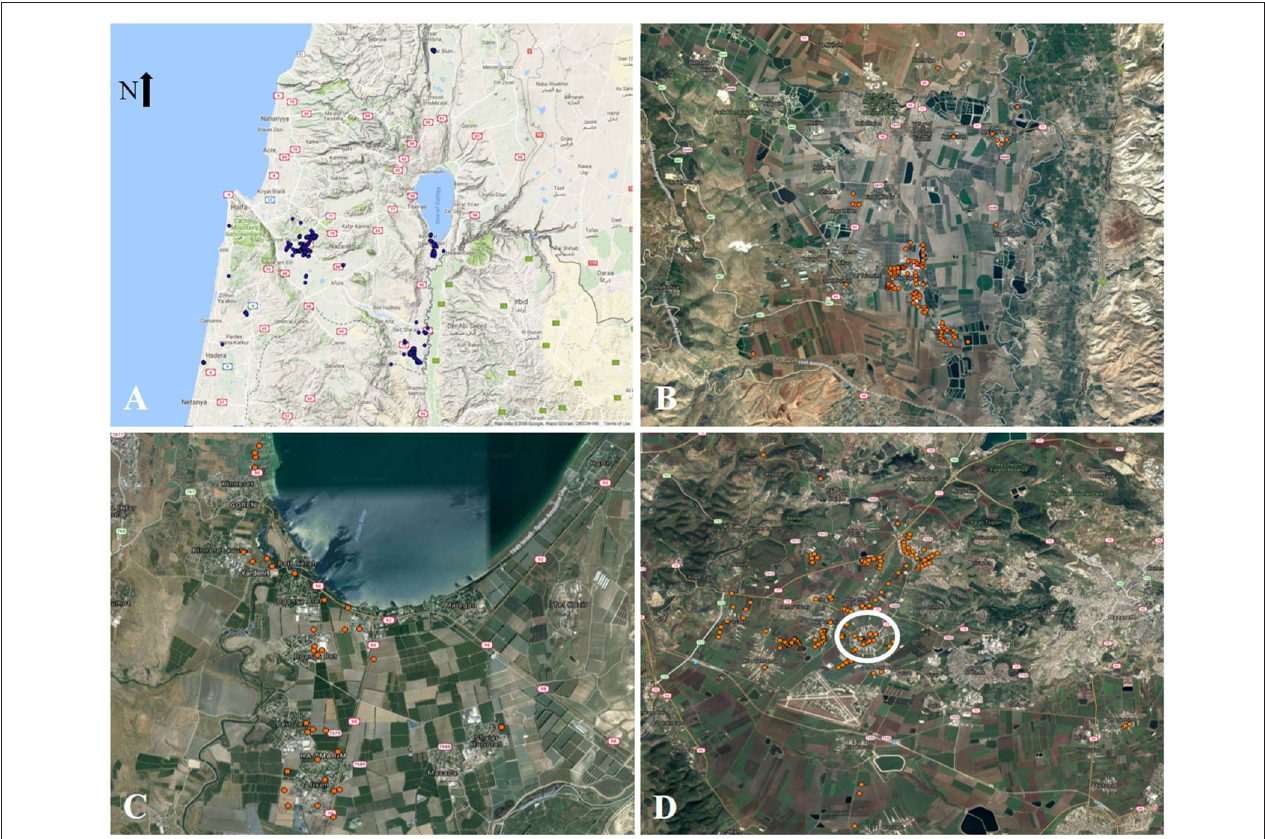
FIGURE 1 | Distribution of Parthenium hysterophorus across Israel. (A) Overview of the current P. hysterophorus distribution region. (B) Specific distribution in the Beit Shean Valley, (C) the Jordan Valley, and (D) the Jezreel Valley.